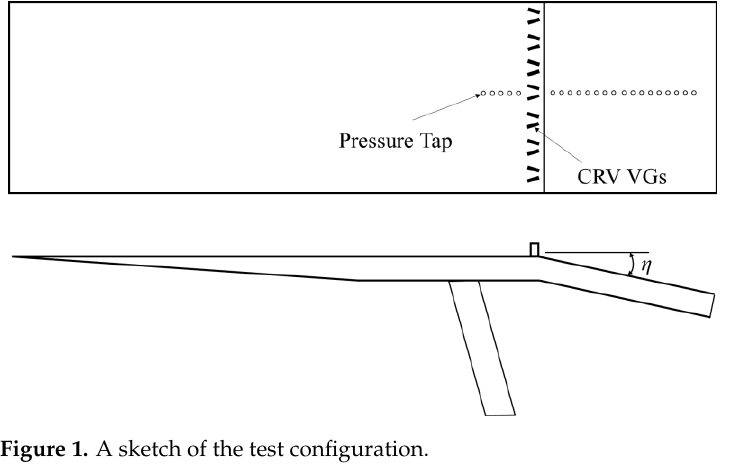
Figure 1. A sketch of the test configuration.